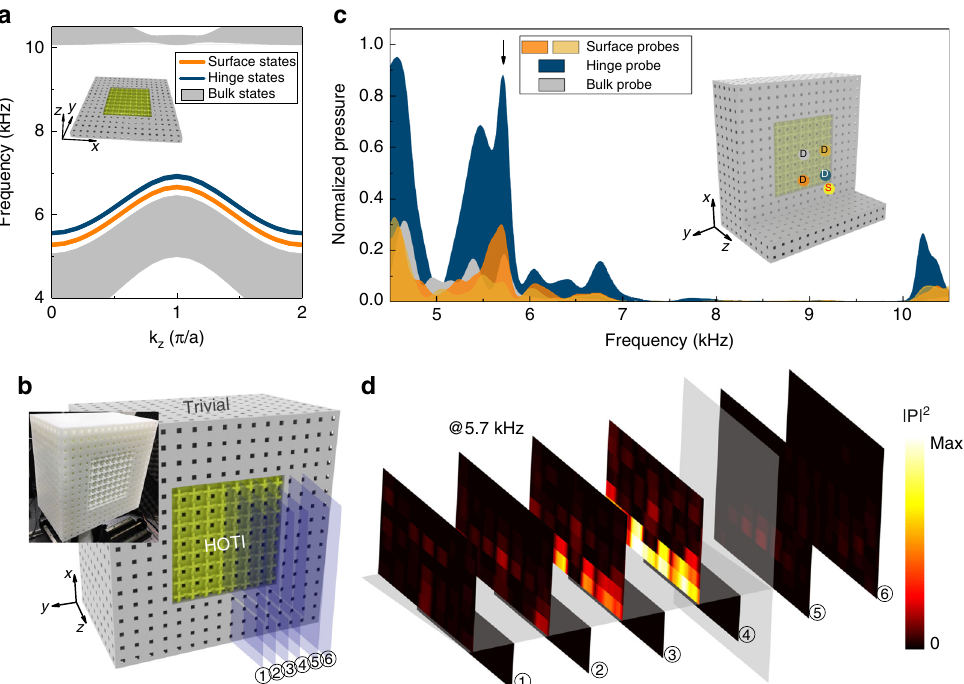
Fig. 3 Topological hinge states: boundary with codimension two. a Calculated acoustic dispersions of the bulk (gray), surface (orange), and hinge (dark blue) states for the supercell with both surfaces and hinges (see the inset). b Photograph of the fabricated hinge sample, consisting of the topological SC (with 8 ´ 8 ´ 10 unit cells) surrounded by the trivial SC in both the x - and y -directions (of thickness 4 a ). c Measured transmission spectra for four types of pump – probe con fi gurations: the bulk probe (gray), two surface probes (orange), and the hinge probe (dark blue). The inset depicts the positions of the source and the probes for the four pump – probe con fi gurations (the color of each probe is the same as in the transmission spectra). d Acoustic pressure pro fi le for the hinge states measured at the excitation frequency of 5.7 kHz (indicated by the black arrow in c ) and presented using slice plots (the locations of the slices are indicated in b a hinge supercell is calculated and presented in Fig. 3a. A sketch of the hinge supercell is depicted in the fi gure, which consists of a block of the topological SC with 8 ´ 8 ´ 1 unit cells (periodic along the z direction) surrounded by a “ wall ” of the trivial SC (the thickness of the wall is 4 a ) in the x - and y -directions. This supercell has four interfaces and four hinges. It is seen from the fi gure that there are surface states (orange curves) and hinge states (dark blue curves), as predicted by the theory. These